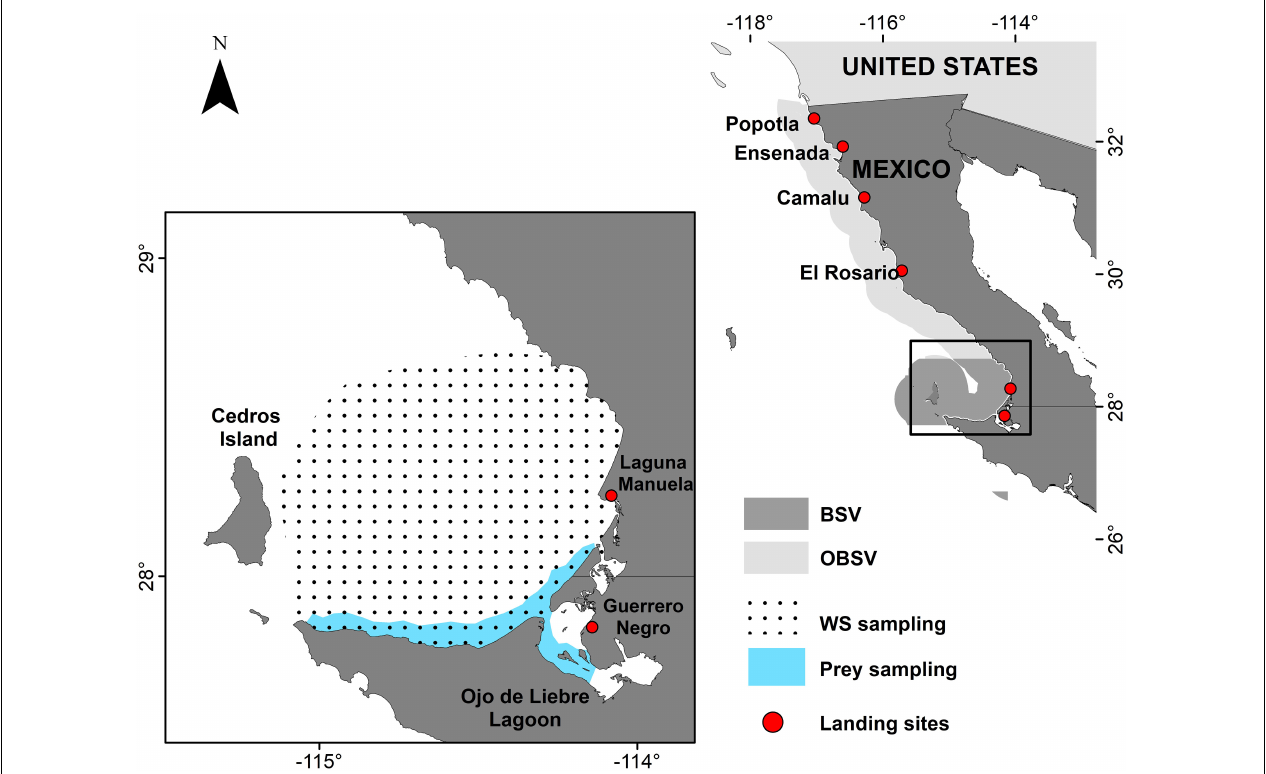
FIGURE 1 | Areas of the Baja California peninsula where white shark muscle samples were collected. BSV, Bahía Sebastián Vizcaíno; OBSV, Outside Bahía Sebastián Vizcaíno. Red points indicate landing sites where white sharks incidentally caught were sampled. Pointed area refers to the places where white sharks were collected inside BSV. The blue area indicates regions where prey inside BSV were collected. Prey samples from Tamburin et al. (2019, 2020) where collected in the pointed area.